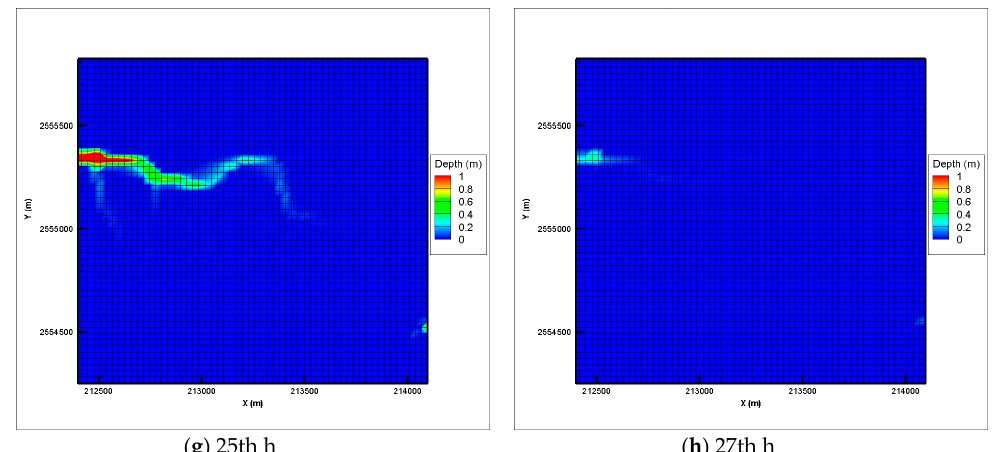
Figure 8. Simulation results of water depth with time during Typhoon Meigi.